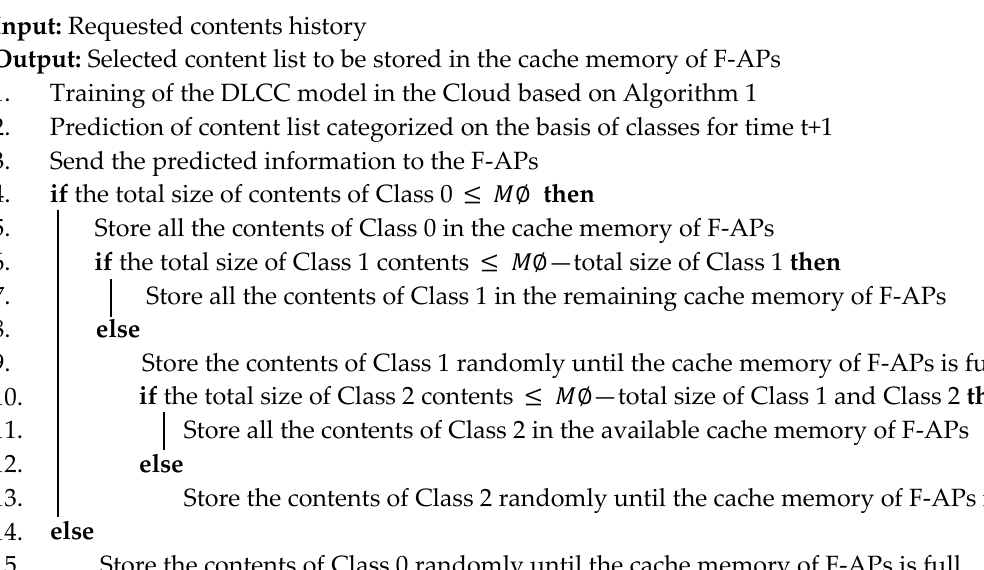
Algorithm 2: Cache content decision process.